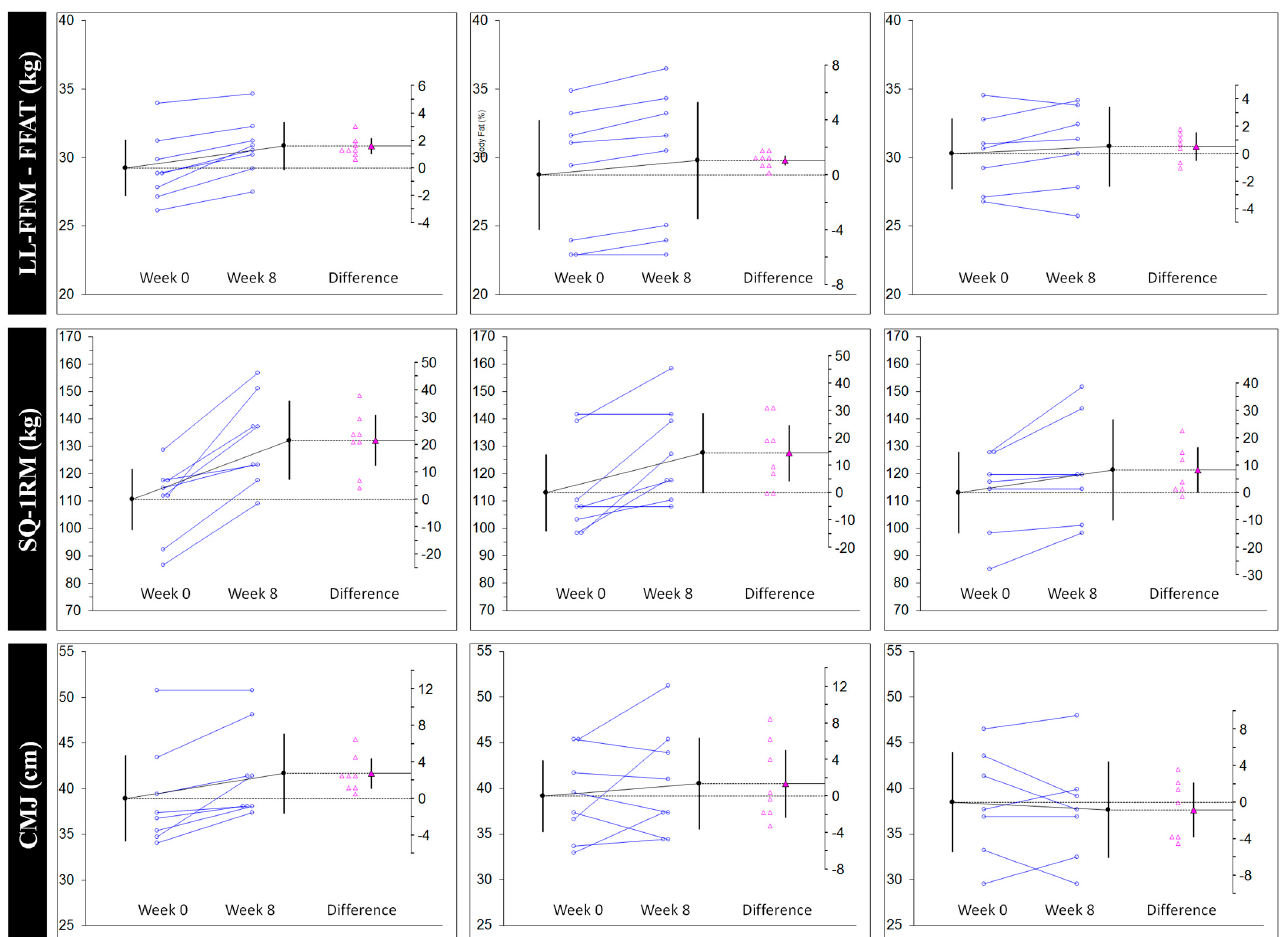
Figure 3. Estimation plots showing pre- and post-intervention values on analyzed variables. Paired data from CS-RT+CrM (left), CS-RT (middle), and control (right) groups are shown as small circles joined by blue lines. The differences between the initial (Week 0) and final (Week 8) means are plotted on a floating difference axis whose zero is aligned with the pre-test mean. The filled pink triangle marks the difference on that axis and the 95% CI on that difference is displayed. The differences are shown as open triangles on the difference axis. FFM and LL-FFM were corrected for fat-free adipose tissue. BMI, body mass index; CI, confidence interval; CMJ, countermovement jump; CrM, creatine monohydrate; CS-RT, cluster-set resistance training; FFAT, fat-free adipose tissue; FFM, fat-free mass; FM, fat mass; LL-FFAT; lower-limb fat-free adipose tissue; LL-FFM; lower-limb fat-free mass; LL-FM; lower-limb fat mass; LL-mass, lower-limb mass; SQ-1RM, 1 repetition maximum for the back squat.